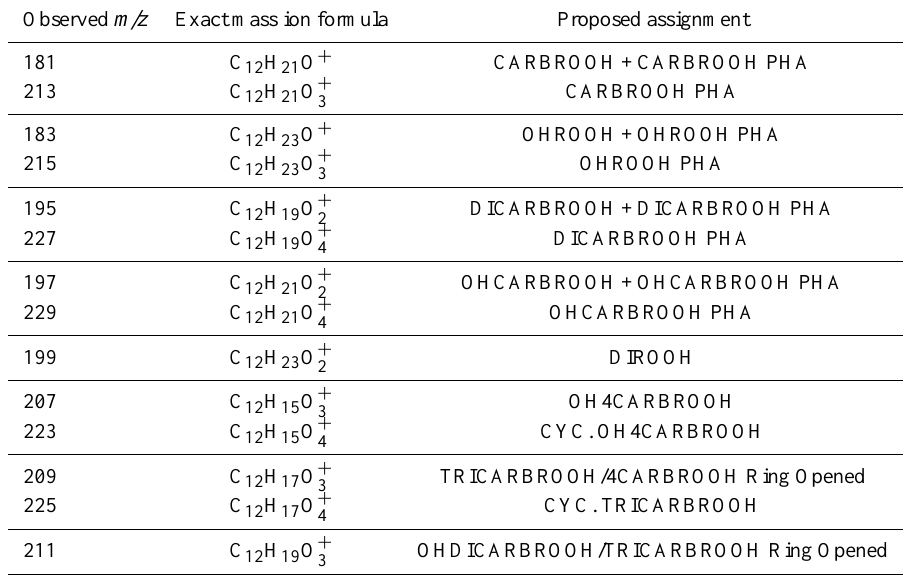
Table 7. Selected ions monitored by the AMS in the cyclododecane system. Observed